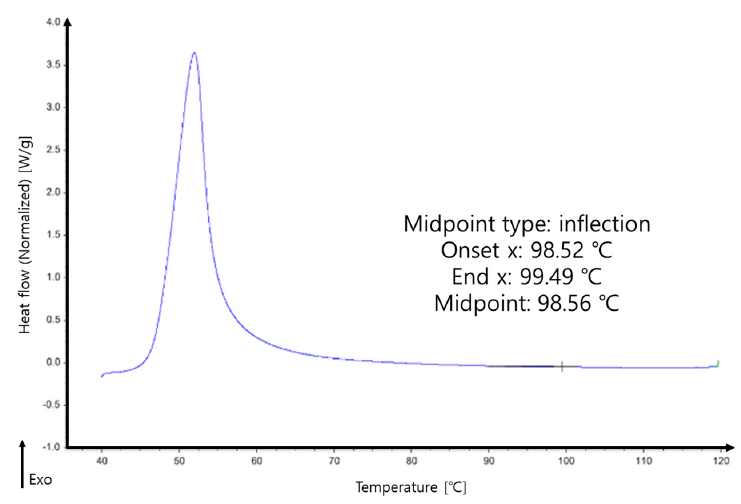
Figure 3. Scanned glass transition temperature of the cured materials of DCPD. Table 1. Glass transition temperature (Tg) of endo-DCPD and endo-DCPD with decelerators after curing reaction.